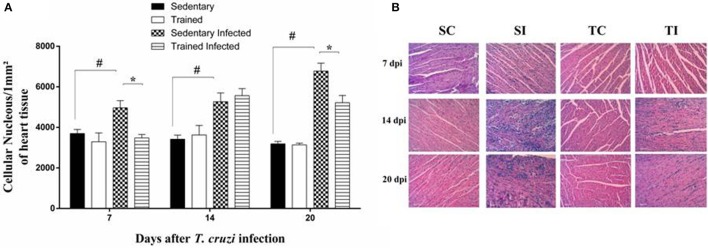
Treadmill exercise decreases T. cruzi-induced heart pathology. (A) Quantification of nuclei in the heart tissue of uninfected sedentary and trained mice and infected sedentary and trained mice 7,14, and 20 days post-infection (DPI). (B) Representative microphotographs (original magnification X 400) of cardiac tissues of mice at 7, 14, and 20 DPI are shown. Data (mean ± SEM) are representative of two independent experiments using five mice per group. *P < 0.05 comparing sedentary-infected mice with trained infected mice. #P < 0.05 comparing sedentary infected with sedentary uninfected mice. Days post infection (DPI), Sedentary control (SC), trained control (TC), sedentary infected (SI), and trained infected (TI).